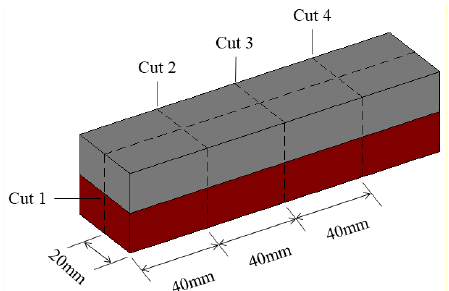
Figure 5. Four cut locations of each sample.